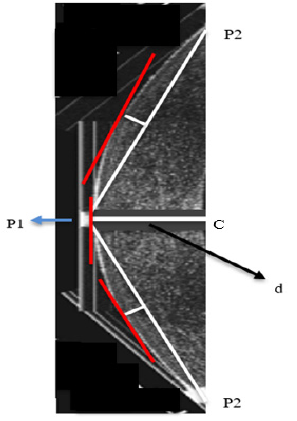
Figure 5. ( a ) Example of the output of the scale-invariant feature transform (SIFT) algorithm. ( b ) Dense features extraction.